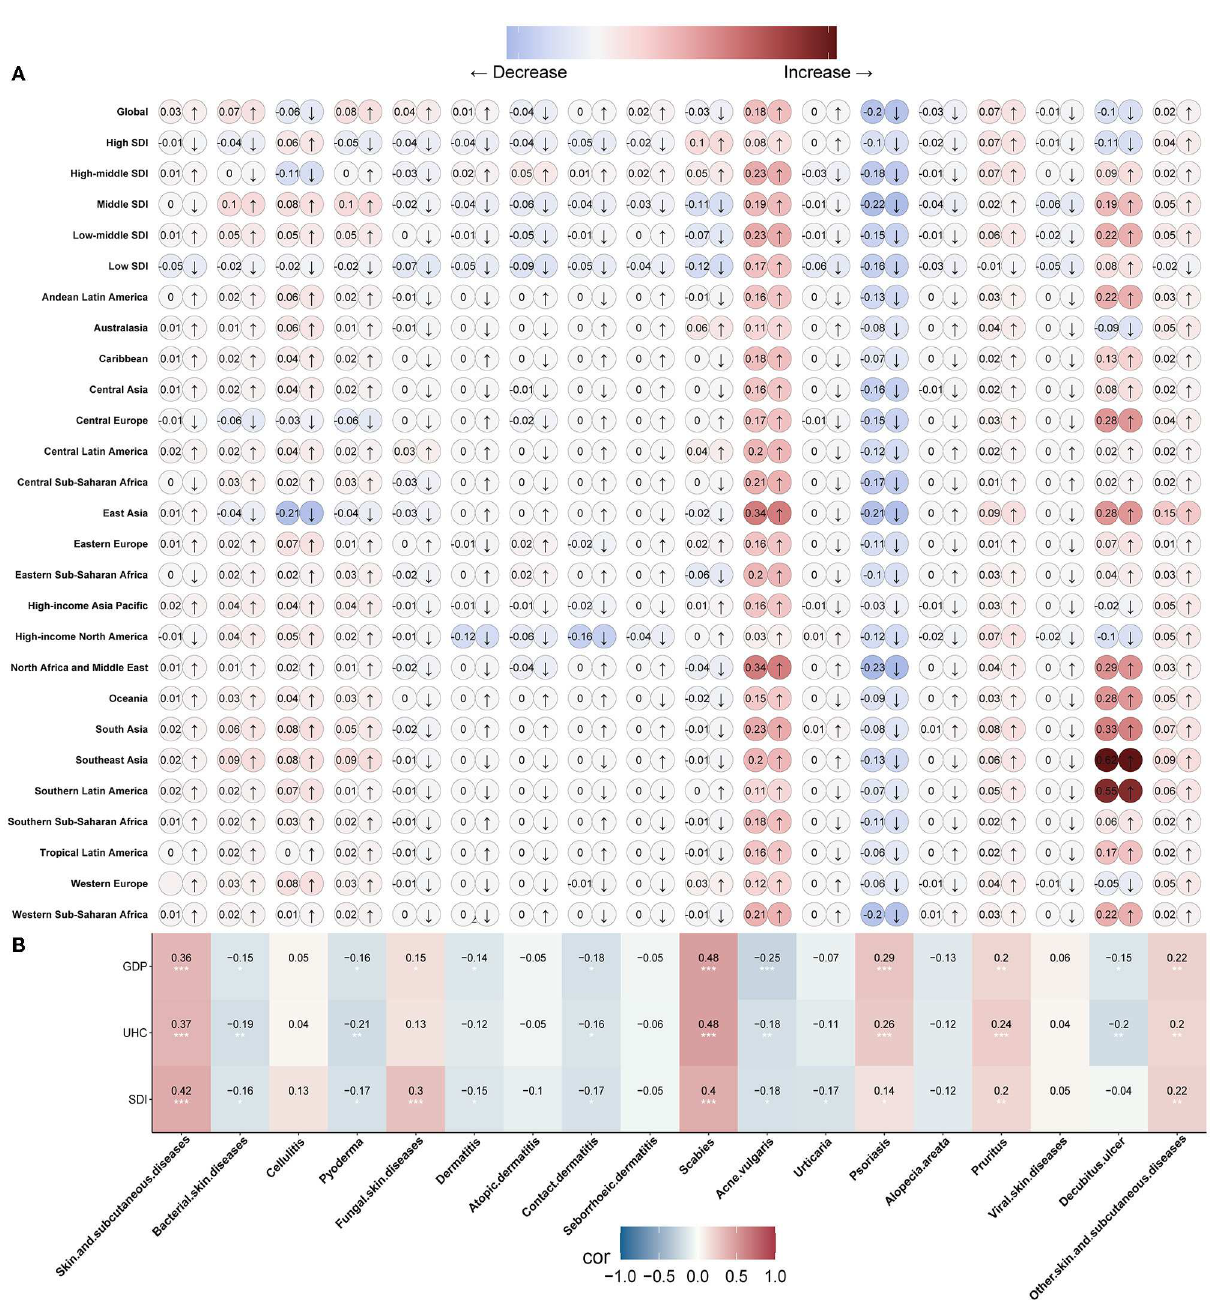
FIGURE5 The trend of skin and subcutaneous diseases and the relevance with social-economic states. (A) Trends of each skin and subcutaneous disease at global, different SDI levels, and different GBD regions (21). (B) Correlation analysis of each skin and subcutaneous disease annual age-standardized incidence rate of changes with SDI, UHC, and GDP among 204 countries and territories in 2019. GBD, Global Burden of Disease; SDI, sociodemographic index; UHC, universal health coverage; GDP, gross domestic product.